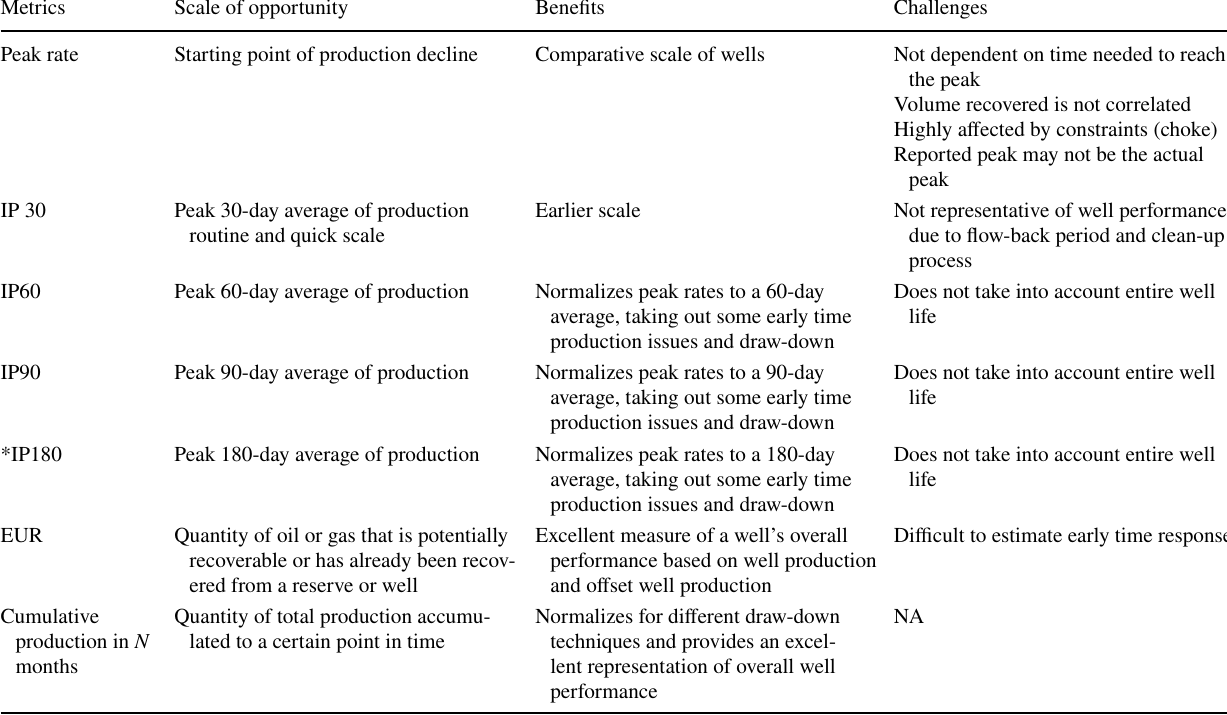
Table 1 Oil and gas production